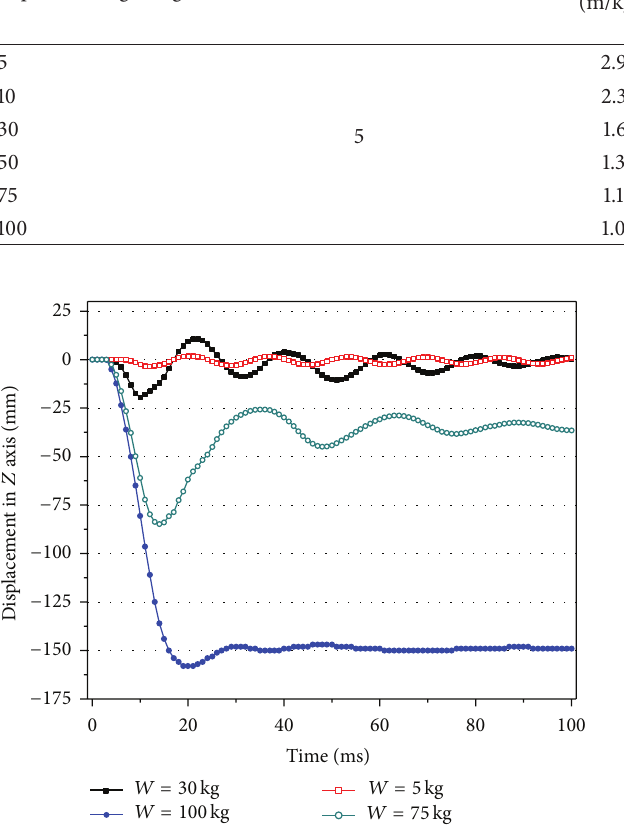
Figure 6: Displacement time history of RC slabs under different explosive weights.